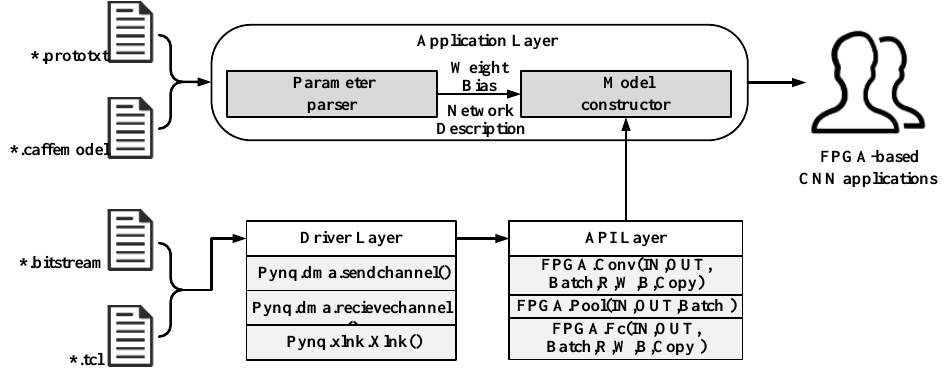
Figure 17. Software framework and mapping flow.